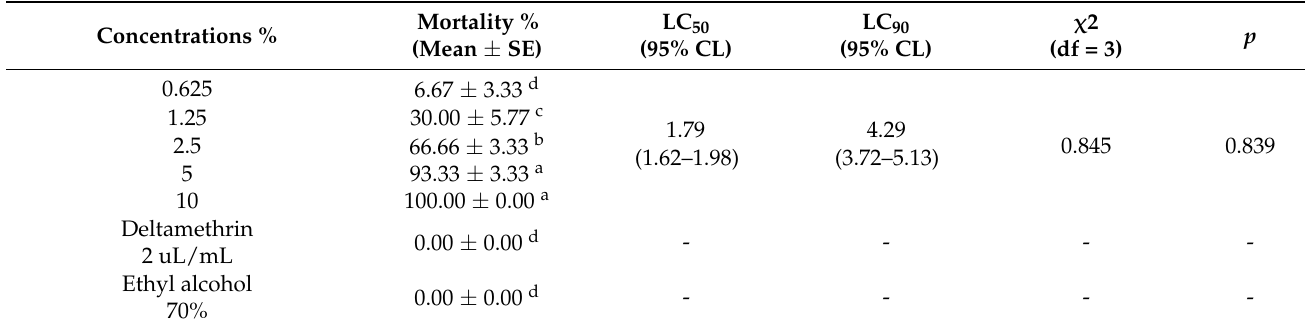
Table 5. Larvicidal activity, and lethal concentrations (LC 50 , LC 90 ) of Lavandula stoechas , against larvae of Musca domestics .